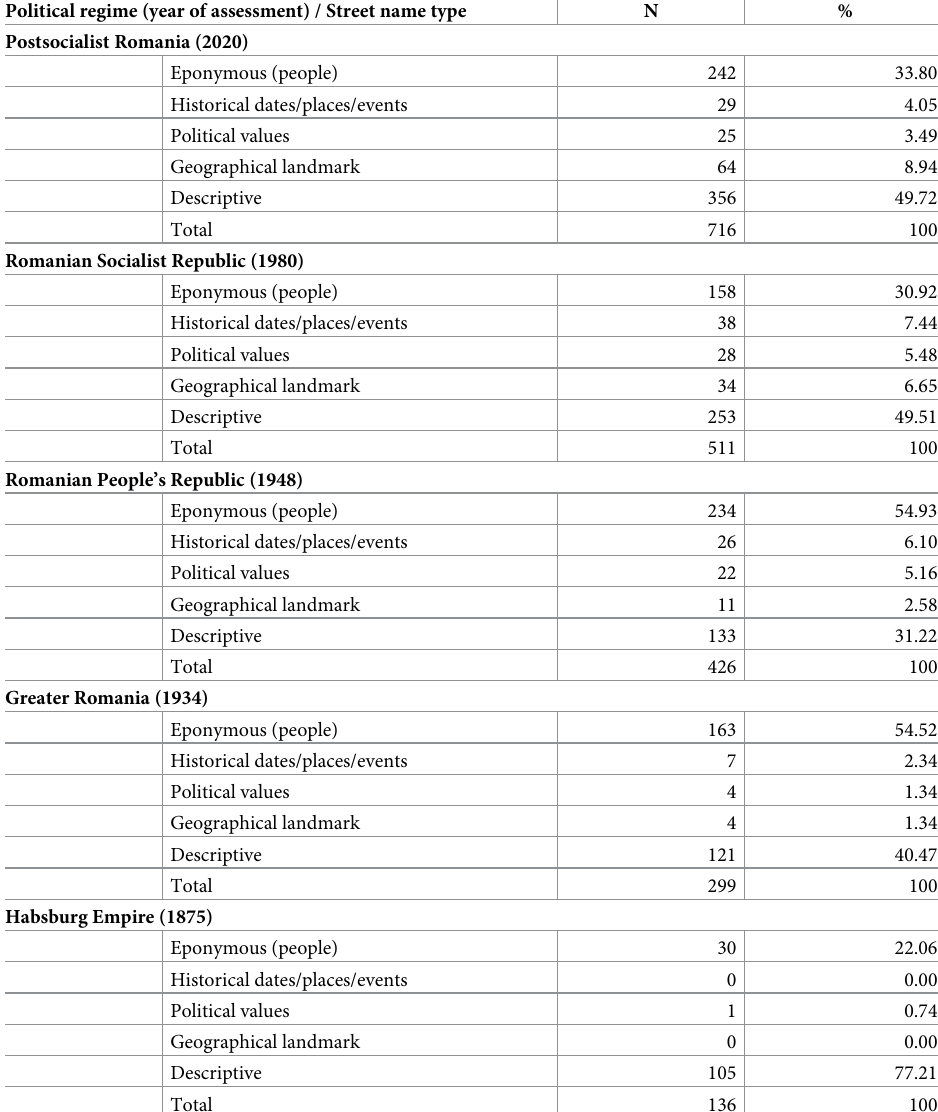
Table 2. Overview of Sibiu’s street name types by political regime. Political regime (year of assessment) / Street name